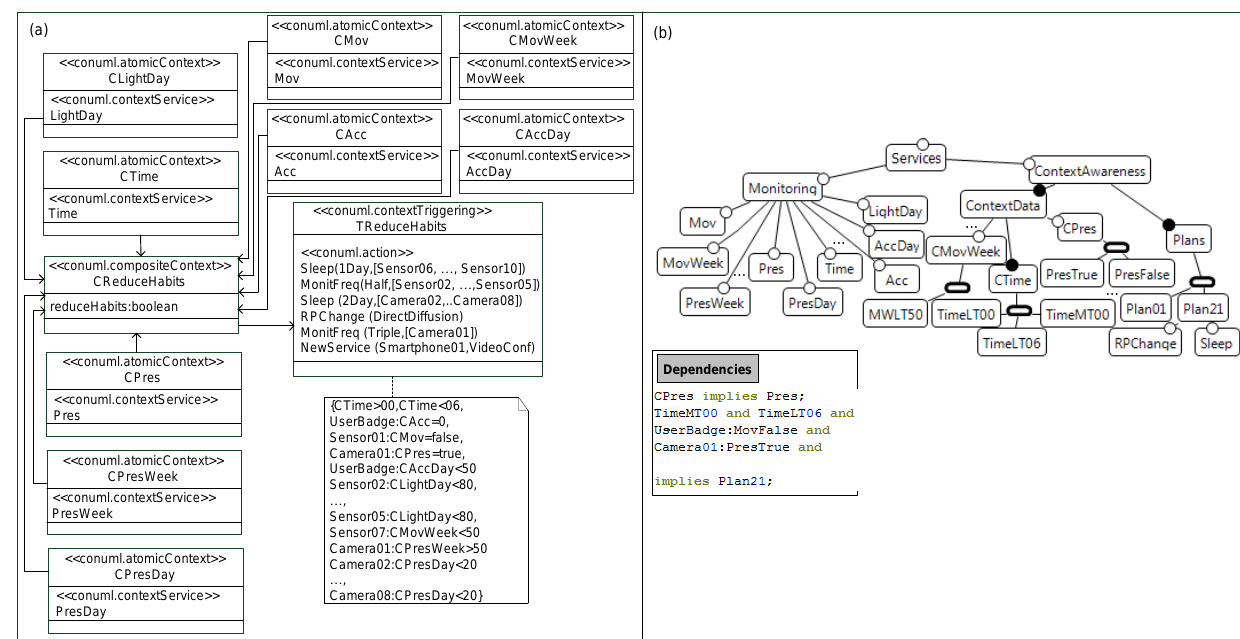
Figure 7. Modeling contexts in our AAL